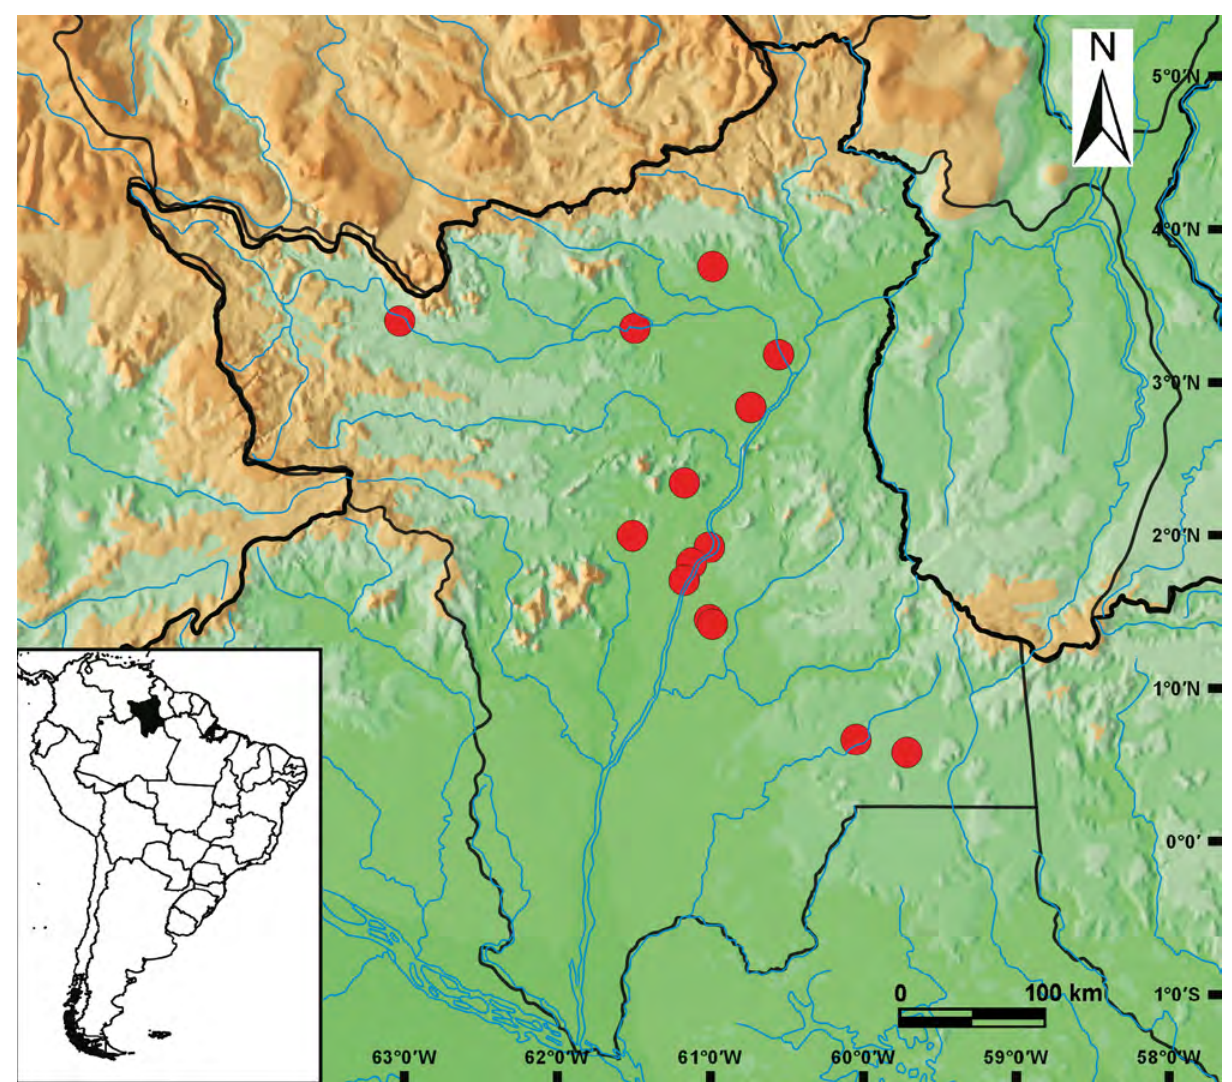
Figure 7. Distribution of the trichodactylid species, Valdivia serrata White 1847, in the state of Roraima,